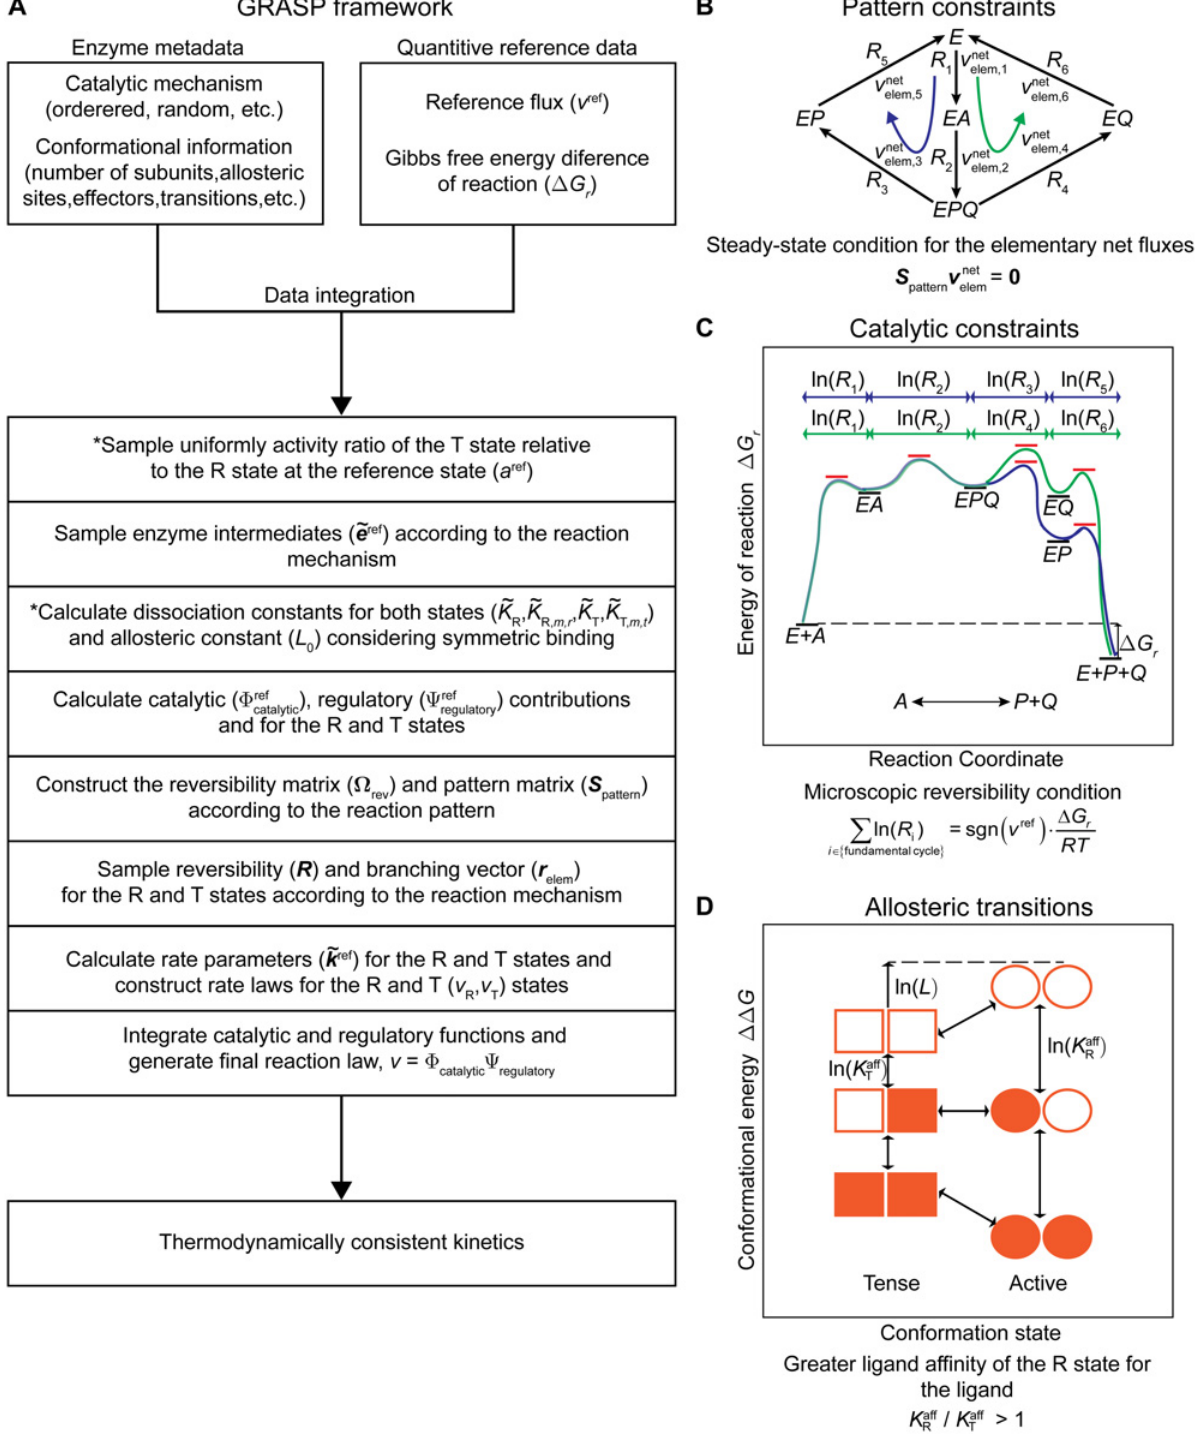
Fig 1. General framework for thermodynamically consistent parameterization and efficient sampling of metabolic reactions. (A) General Reaction Assembly and Sampling Platform (GRASP) workflow. The steps indicated by * are only required for parameterizing and sampling allosteric reactions. (B) Example of pattern constraints present in a random-order Uni-Bi mechanism with the formation of a ternary complex ( EPQ ). The intermediate EPQ splits to the EP and EQ enzyme intermediates. This behaviour can be modelled by uniformly sampling the solution space for the steady-state elementary net fluxes v net elem , which captures the stoichiometric properties of the reaction pattern. (C) Illustration of energetic constrains in the previous mechanism. There are 2